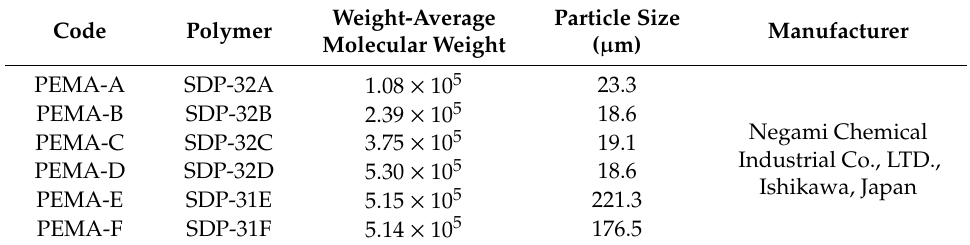
Table 1. Polymer powders